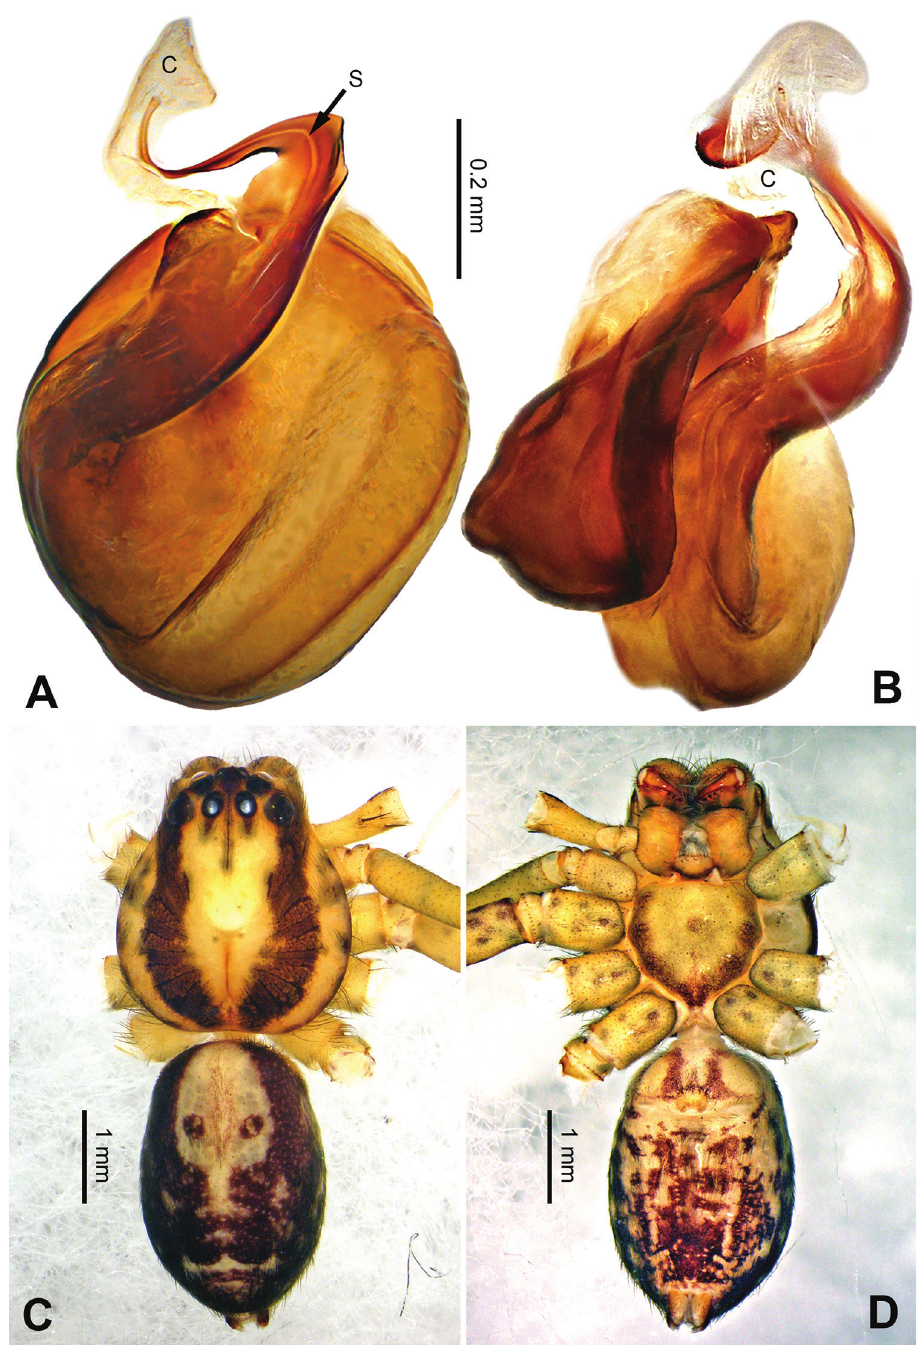
Figure 11. Pseudopoda gexiao Zhao & Li, sp. n., male holotype. A Bulb, ventral view B Bulb, dorsal view C Habitus, dorsal view D Habitus, ventral view. Scale bar equal for A , B